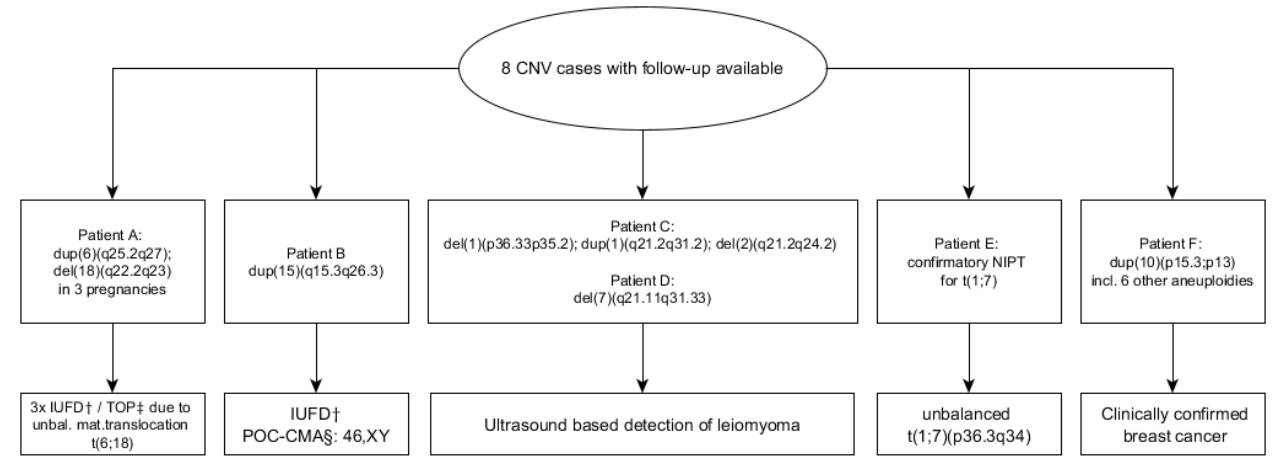
Figure 3. Flowchart of CNV-positive cases and their clinical outcome. CNVs detected by NIPT had a size ranging from 9–58 megabases. The NIPT result from patient F presented a combination of a non-mosaic duplication on chromosome 10 and six RAAs in a mosaic form. † intra-uterine fetal death; ‡ termination of pregnancy; § analysis of the product of conception by chromosome microarray.